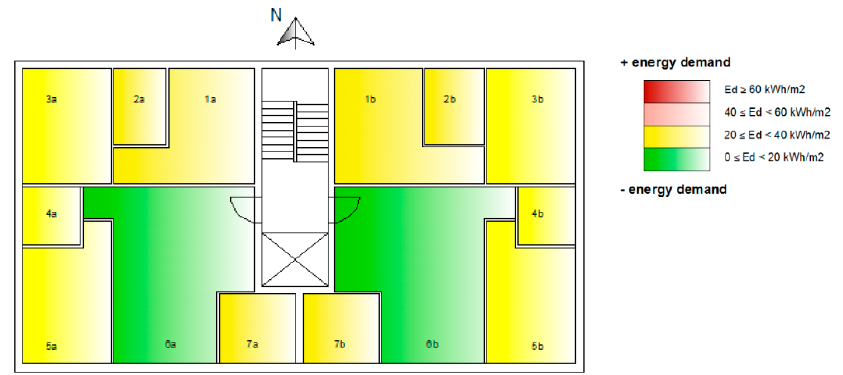
Figure 8. Colour map of the energy demand (Ed) evaluated by replacing the external layer of infills with a new one having better thermal insulation properties.